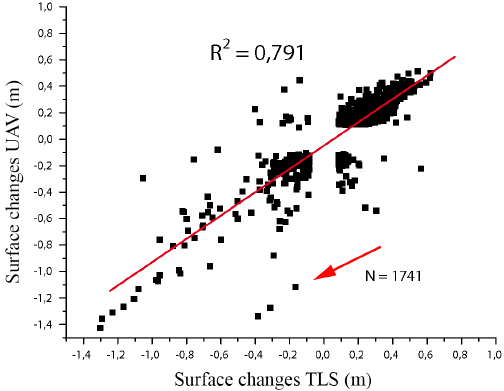
Figure 13. Comparison of surface changes of the 2013 to 2015 epoch for the UAV and the TLS data, which are detected in both data